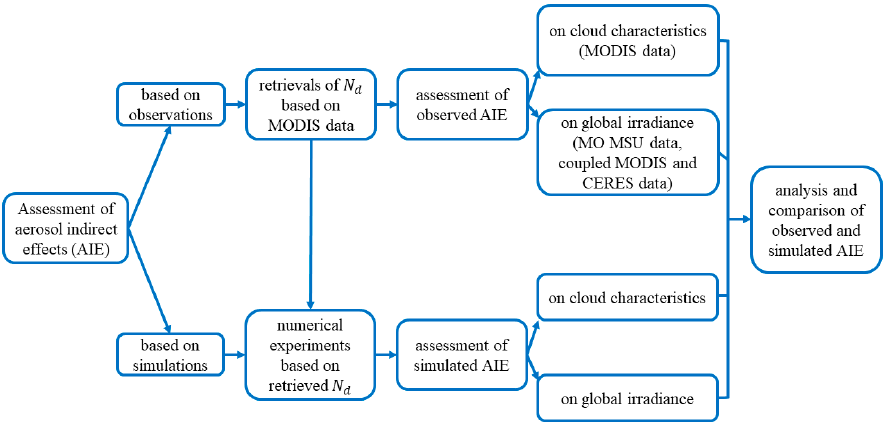
Figure 1. A flowchart of research aerosol indirect effects over Moscow using observations and numerical experiments.